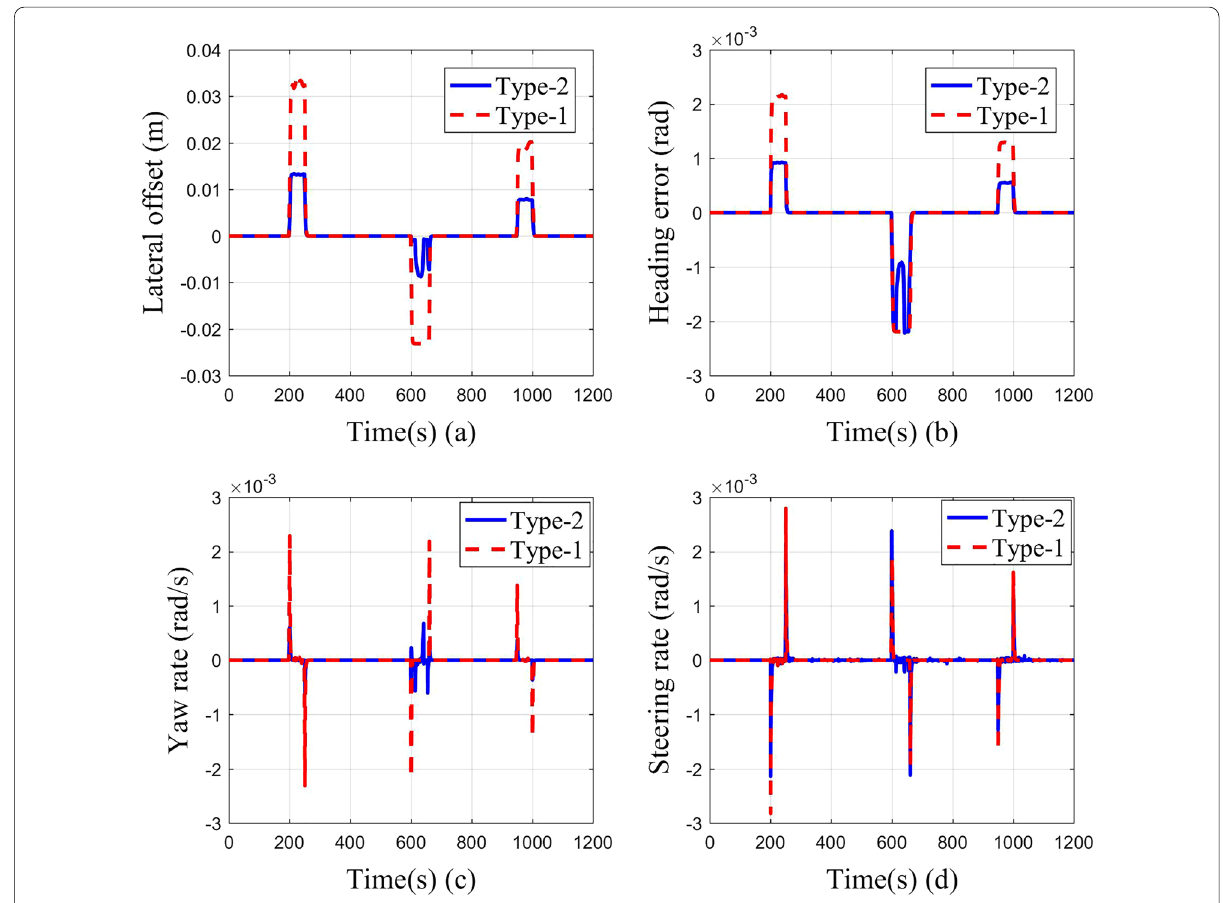
Figure 8 Response of vehicle states in accordance with measured vehicle speed-I